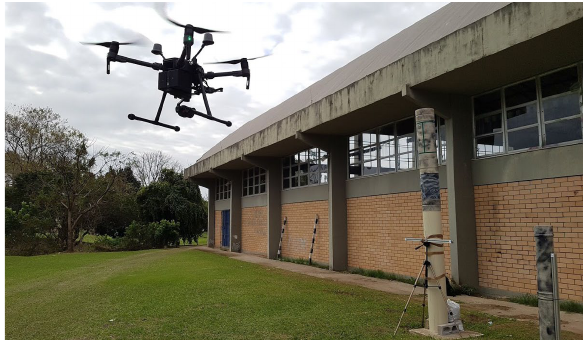
Figure 14. Experiment setup. RPA during acquisition of images of a PVC pipe (riser simulacrum) for photogrammetric measurement.